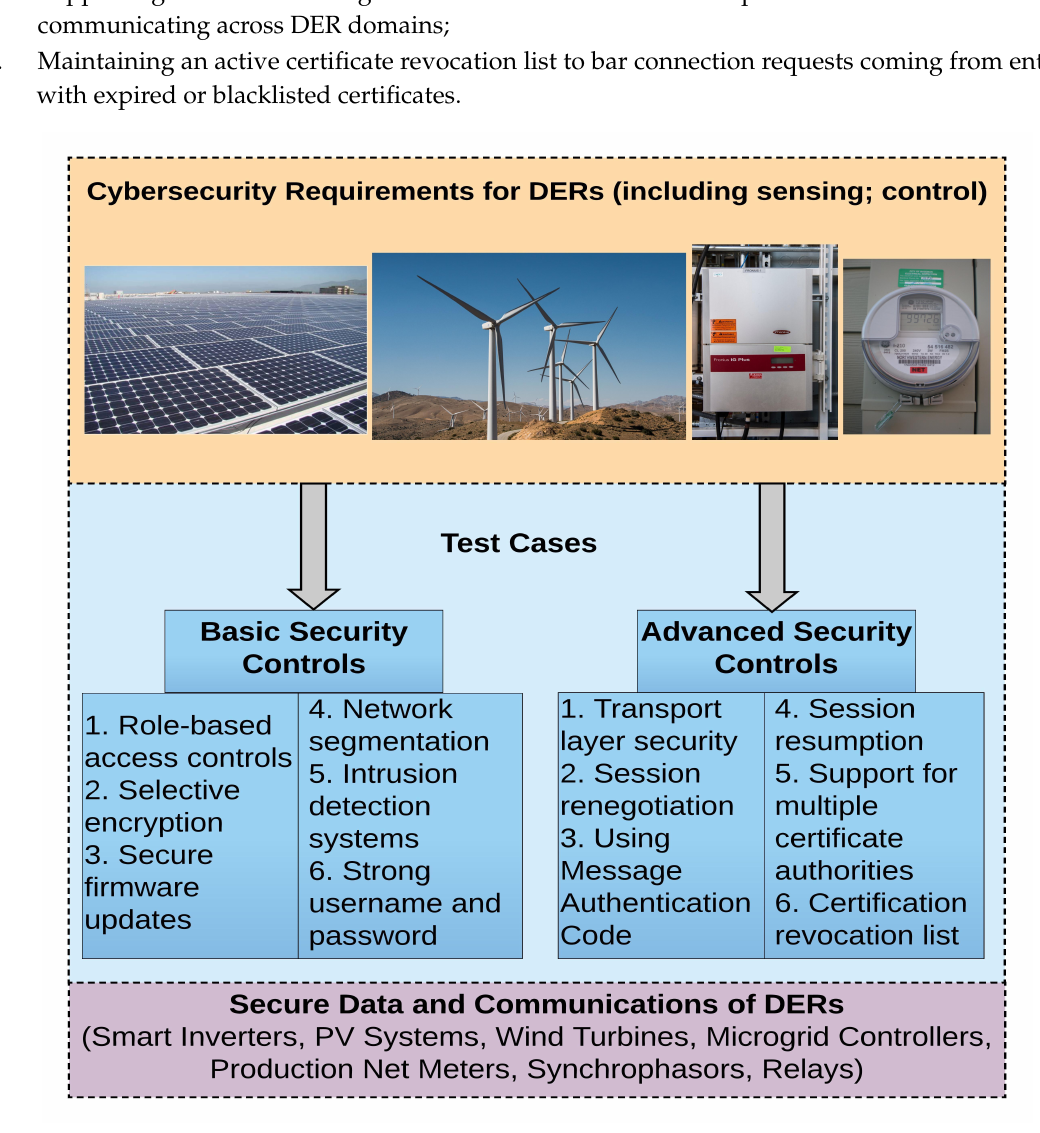
Figure 4. The DER security requirements derived from the survey in Sections 3 and 4. Figure numbers from left to right: NREL 19487 (PV system), NREL 50709 (wind farm), NREL 45576 (smart inverter), and NREL 21394 (smart